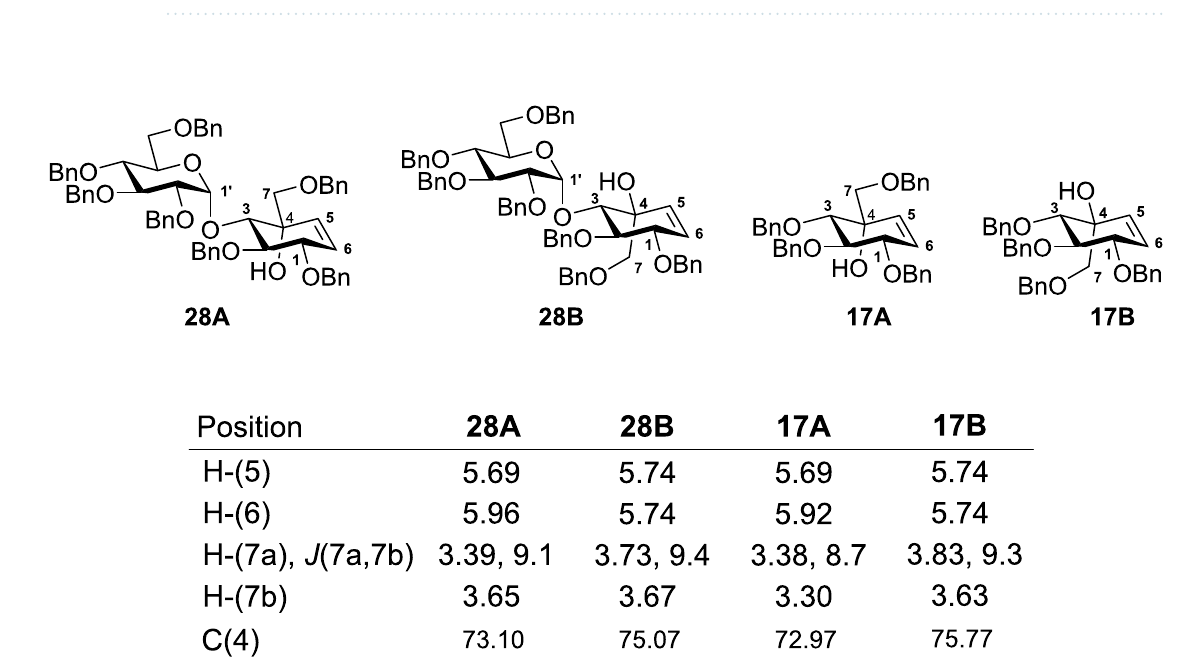
Table 2. Reaction condition optimization for RCM for compounds 28A and 28B .